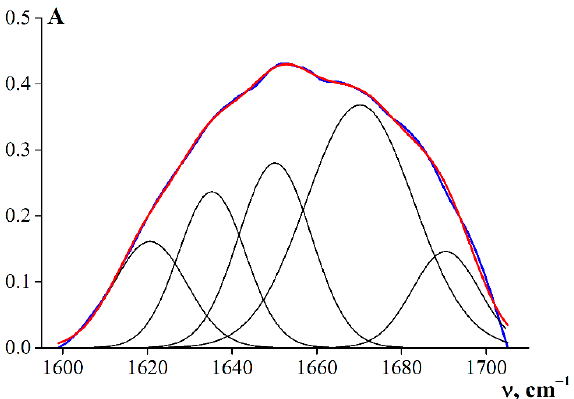
Figure 3. Decomposition of the band components of the amide I band using a Gaussian distribution (R 2 =